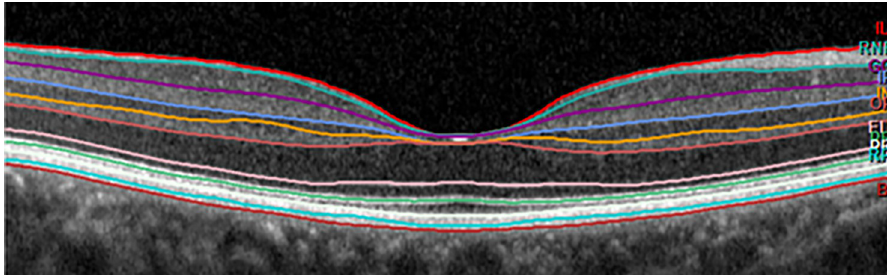
Fig 2. Macular Heidelberg spectralis scan with the individual retina layers. From top to bottom: Choroid; RPE, retina pigment epithelium; PR, photoreceptors; OPL, outer plexiform layer; INL, inner nuclear layer; IPL, inner plexiform layer; GCL, ganglion cell layer; RNFL, retina nerve fibre layer; ILM, inner limiting membrane.